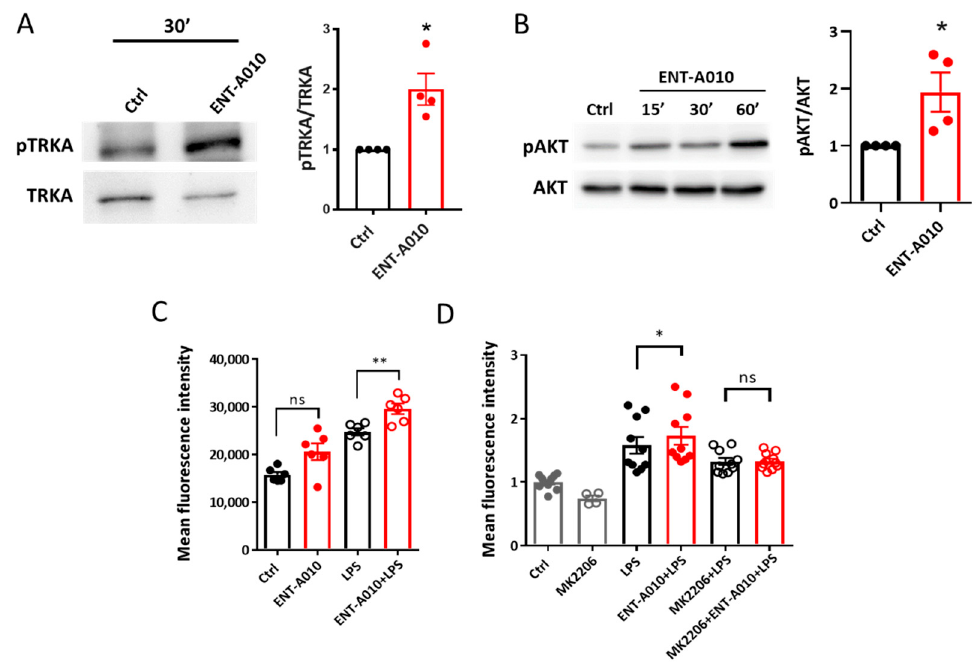
Figure 6. ENT-A010 induced TRKA and AKT signaling and promoted phagocytosis in microglial cells. ( A ) Primary microglia cells were treated for 30 min with 1 µ M ENT-A010 or DMSO (Ctrl). Cell lysates were analyzed by WB for phospho- and total TRKA ( A ). ( B ) BV2 cells were treated for 15, 30 or 60 min with 1 µ M ENT-A010 or for 60 min with DMSO (Ctrl) and analyzed for phospho- and total AKT by WB. A representative out of 4 experiments is shown ( A , B ). Signal intensities of pTRKA, total TRKA, pAKT and total AKT were measured and in each experiment, the ratio of pTRKA/TRKA and pAKT/AKT was set as 1 for Ctrl samples. ( B ) shows the quantification of pAKT/AKT at 60 min of treatment. ( C , D ) Primary microglia were treated with 1 μ M ENT-A010 on two consecutive days, and 1 h after the second treatment, they were stimulated with 100 ng/mL LPS. In ( D ), cells were pre-treated with the AKT inhibitor MK2206 (2.5 µ M) 30 min prior to the first ENT-A010 treatment. Twenty-four h after the LPS treatment, fluorescently labeled A β was applied for 2 h to the cells, followed by flow cytometry. Data are shown as mean ± SEM, n = 4 for ( A ), n = 4 for ( B ), n = 6 ( C ), n = 4–10 ( D ), *: p < 0.05 **: p < 0.01, ns: non-significant.